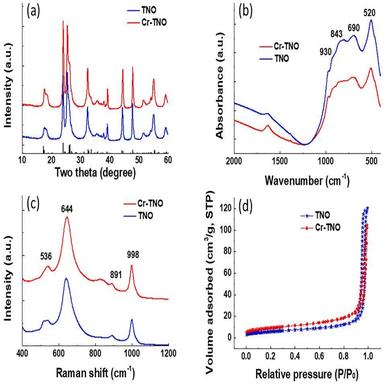
Characterization of the pristine and doped TNO. (a) XRD pattern, (b) FTIR spectrum, (c) Raman spectrum, and (d) N2 adsorption/desorption isotherms of the pristine TNO and Cr-TNO.